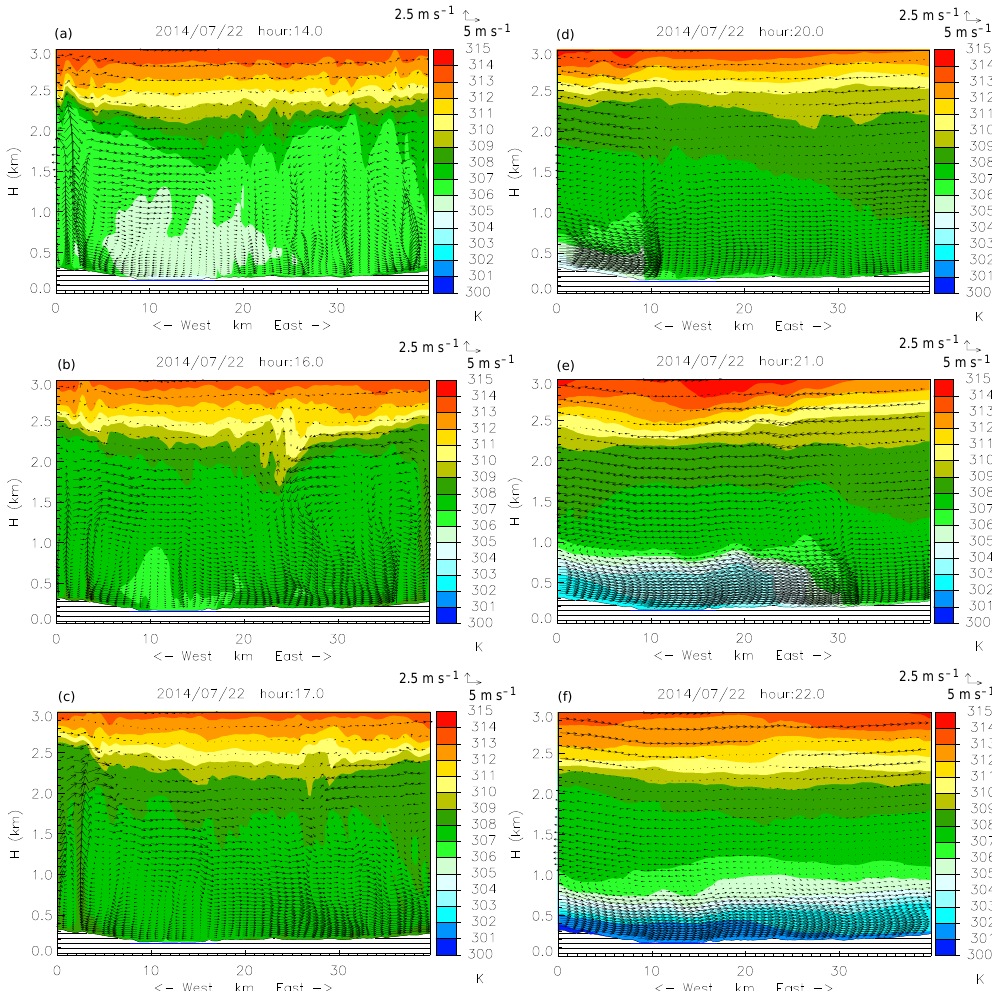
Figure 10. East–west direction cross sections along 38.215 ◦ N (Cs1, crosses the lake near Montante platform, Fig. 9a) of potential temper- ature (filled contours) and wind vectors in the plane of the cross section (arrows), at different hours (indicated in the top of each figure) in the LAKE1 experiment at 250m horizontal resolution. The wind vertical and horizontal scales are indicated in the upper right corner of each figure. The blue line on the surface level indicates the location of the